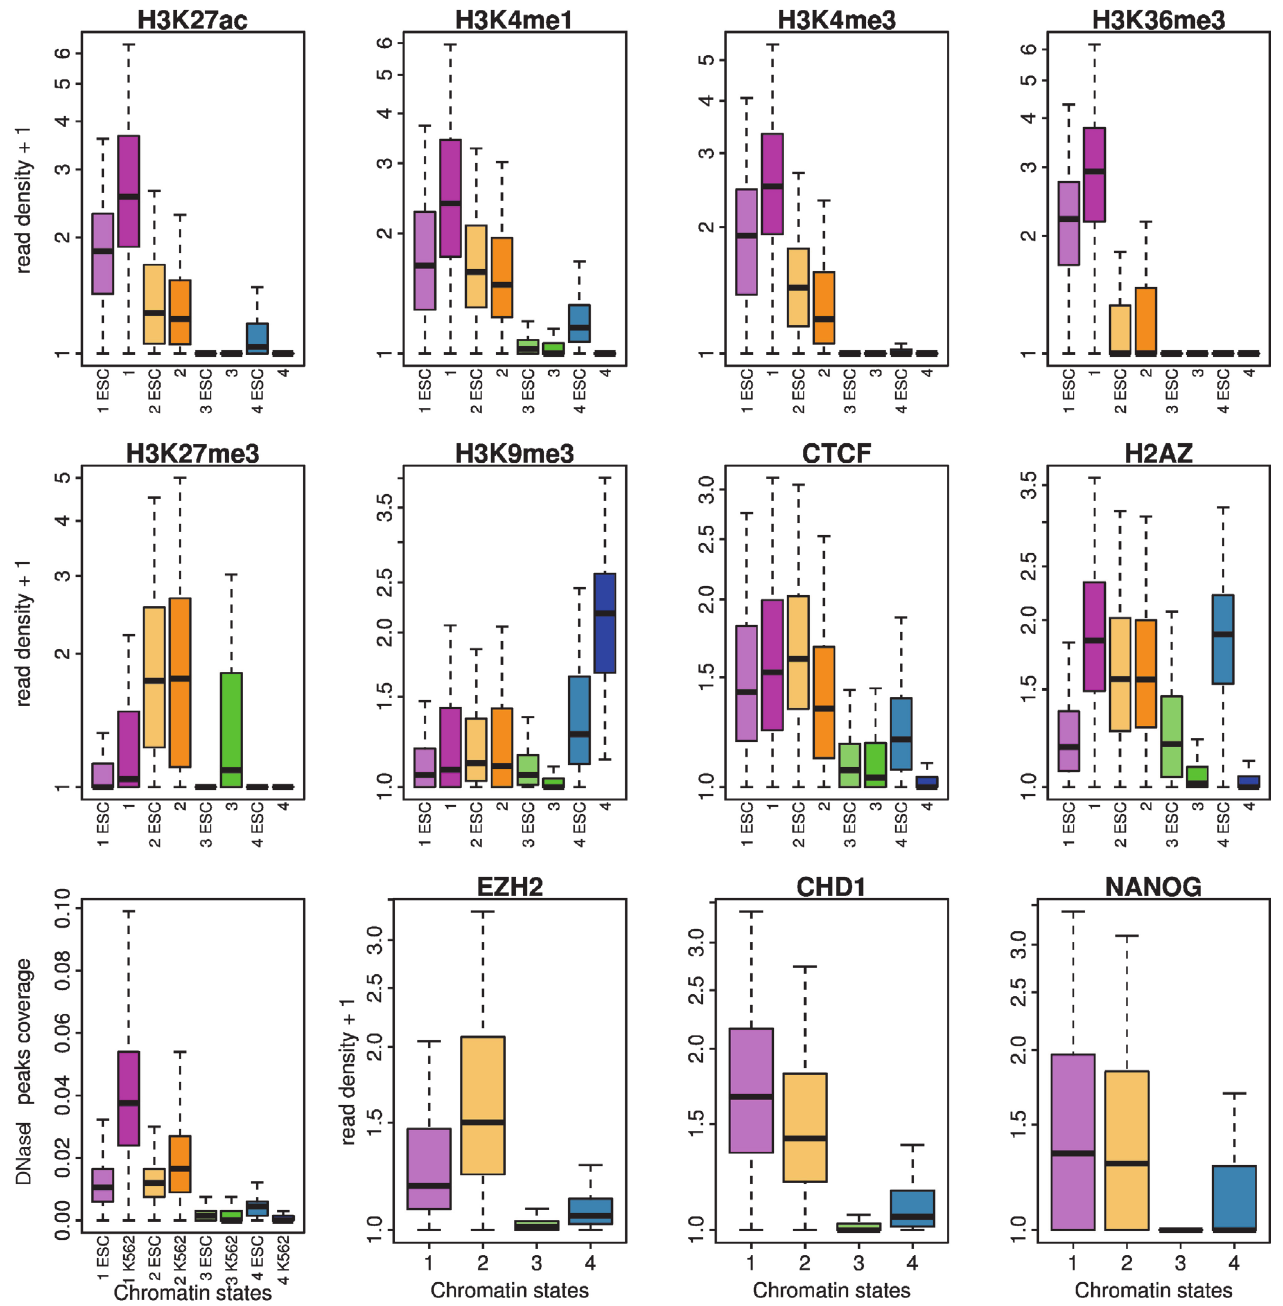
Figure 2. (First two rows) Repartition of epigenetic marks in the four prevalent chromatin states of H1hesc cell line: EC1 (light pink), EC2 (light orange), EC3 (light green), EC4 (light blue) and of differentiated cell lines: C1 (pink), C2 (orange), C3 (green), C4 (blue). Boxplots of the decimal logarithm of histone mark ChiP-seq read density in 100 kb non-overlapping windows per chromatin state. (Third row) Boxplots of the coverage of DNase1 hypersentive peaks in 100 kb non-overlapping windows per chromatin state in H1hesc and K562 cell lines and the decimal logarithm of EZH2, CHD1 and NANOG ChiP-seq read density in 100 kb non-overlapping windows per chromatin state in H1hesc cell lines. Same color coding as above.